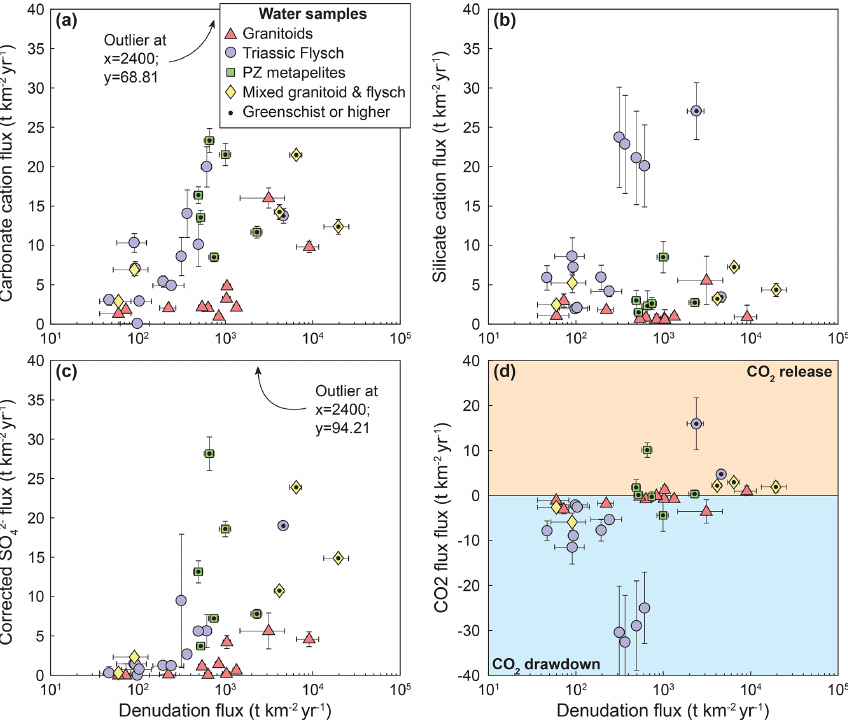
Figure A6. Inferred weathering fluxes. (a–c) Data from Fig. 5a–c and (d) data from Fig. 7 converted to fluxes by using mean annual precipitation as a runoff estimate. One outlier with exceptional precipitation values is not plotted in (a) and (b) .